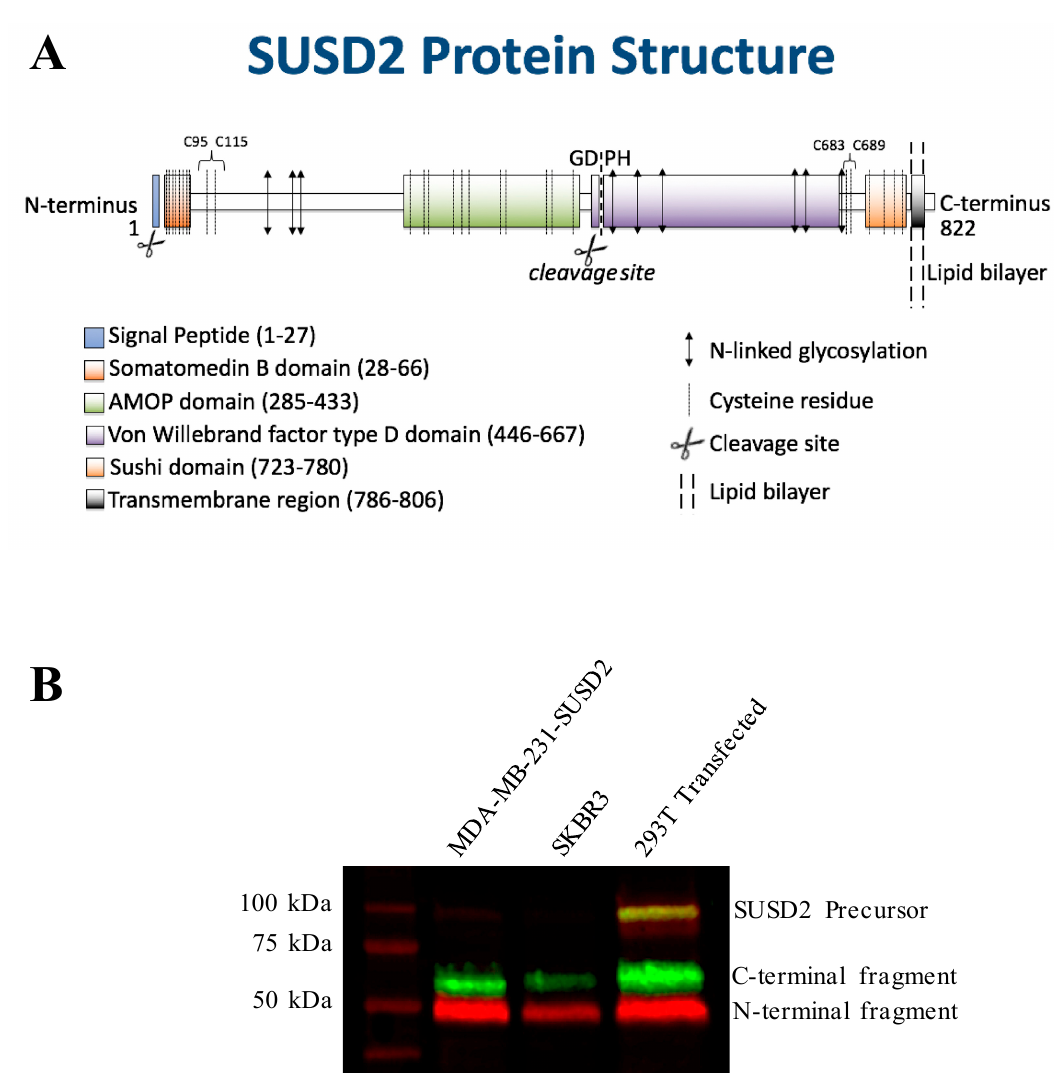
Figure 1. ( A ) SUSD2 is a type I transmembrane protein composed of 822 amino acids (a.a.). The domains are indicated by the colored rectangles as labeled. The a.a. span of each domain is indicated in parentheses. The GDPH sequence is located in the von Willebrand factor type D domain, and is the site of protein cleavage. The double-headed arrows represent N-linked glycosylation sites. Cysteine residues are represented by dashed lines. Specific cysteines are indicated by C followed by the a.a. location. A scissors indicates the site of protein cleavage, and the membrane bilayer is a double-dashed line. ( B ) Western immunoblot analysis of SUSD2. Whole cell lysates were generated from stable MDA-MB-231-SUSD2, wild-type SKBR3, and 293T cells transiently transfected with a SUSD2 expression plasmid. Cell lysates were separated by gel electrophoresis and transferred to a polyvinylidene difluoride (PVDF) membrane. Membranes were probed with anti-N-terminal (red) and anti-C-terminal (green) SUSD2 antibodies. Yellow staining indicates the presence of both SUSD2